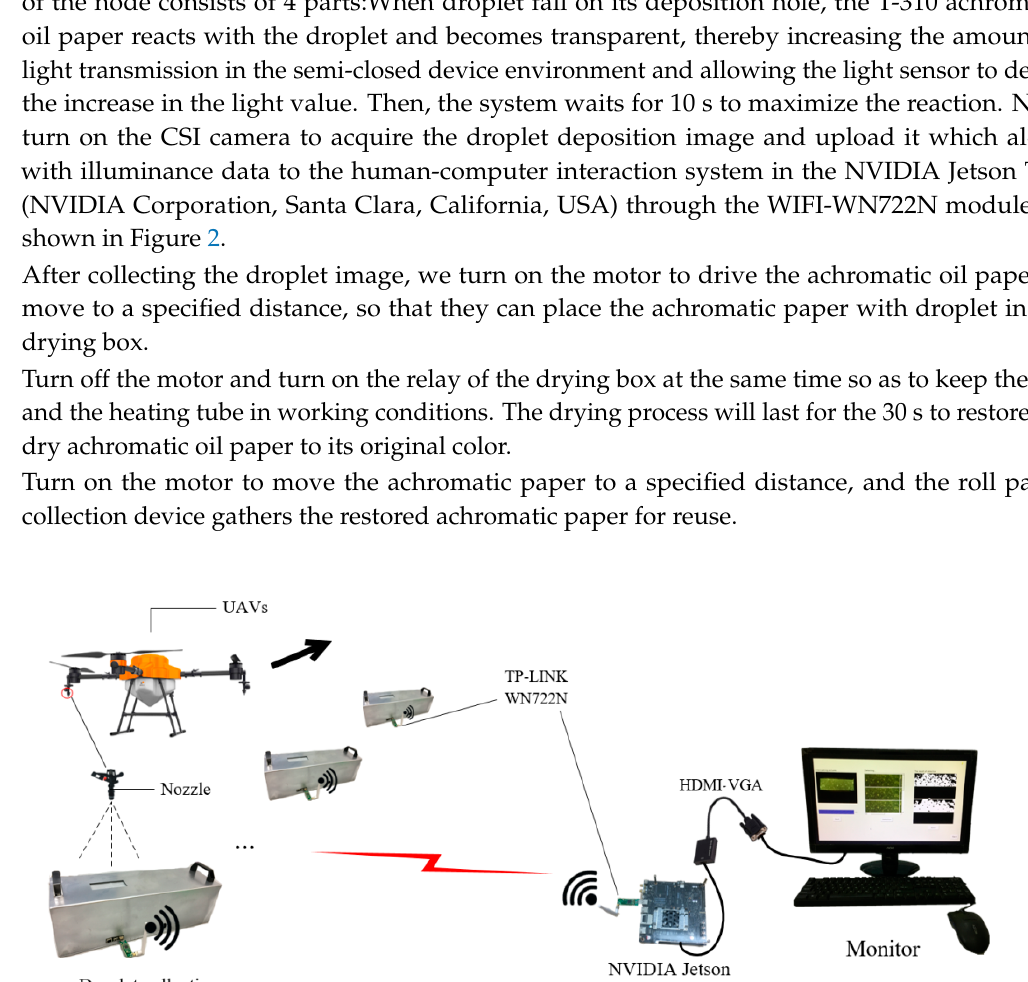
Figure 2. Scene structure of system work. UAV: Unmanned Aerial Vehicle